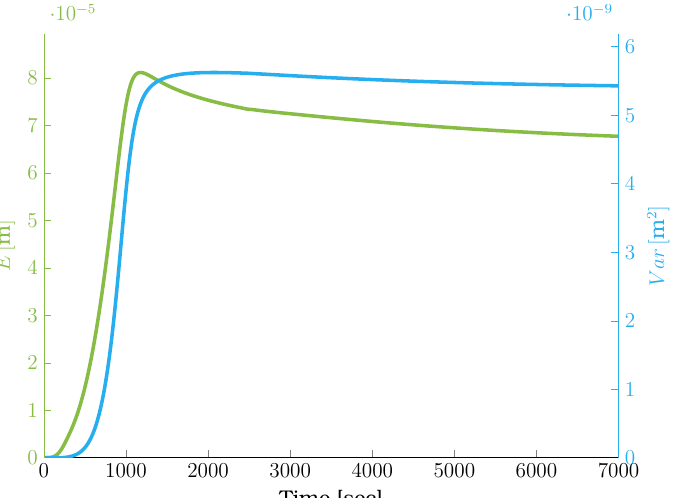
Figure A2. The evolution of the expected value and the variance in the case of the non-isothermal continuous system.